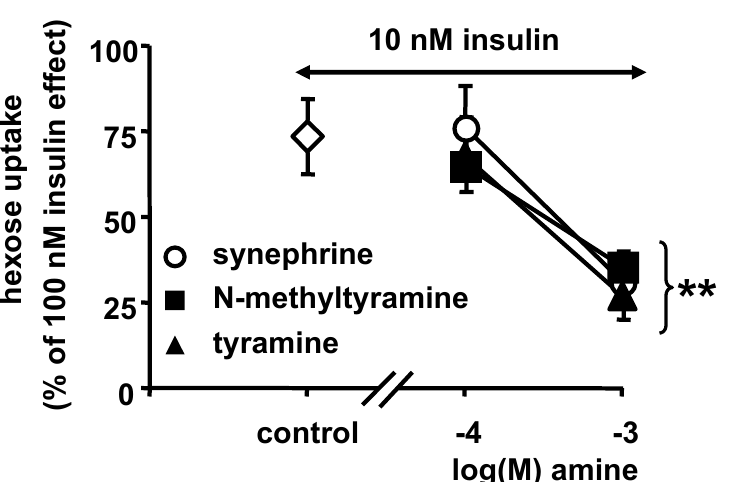
Figure 5. Influence of NMT, tyramine and synephrine on insulin-dependent stimulation of glucose transport in human adipocytes. The submaximal stimulation of hexose uptake by 10 nM insulin was expressed as the percentage of the maximal response to 100 nM insulin (set at 100%, with basal 2-DG uptake set at 0%). Insulin was tested alone (control, open diamond) and in the presence of the indicated concentrations of amines. Mean ± SEM of six preparations of human adipocytes.